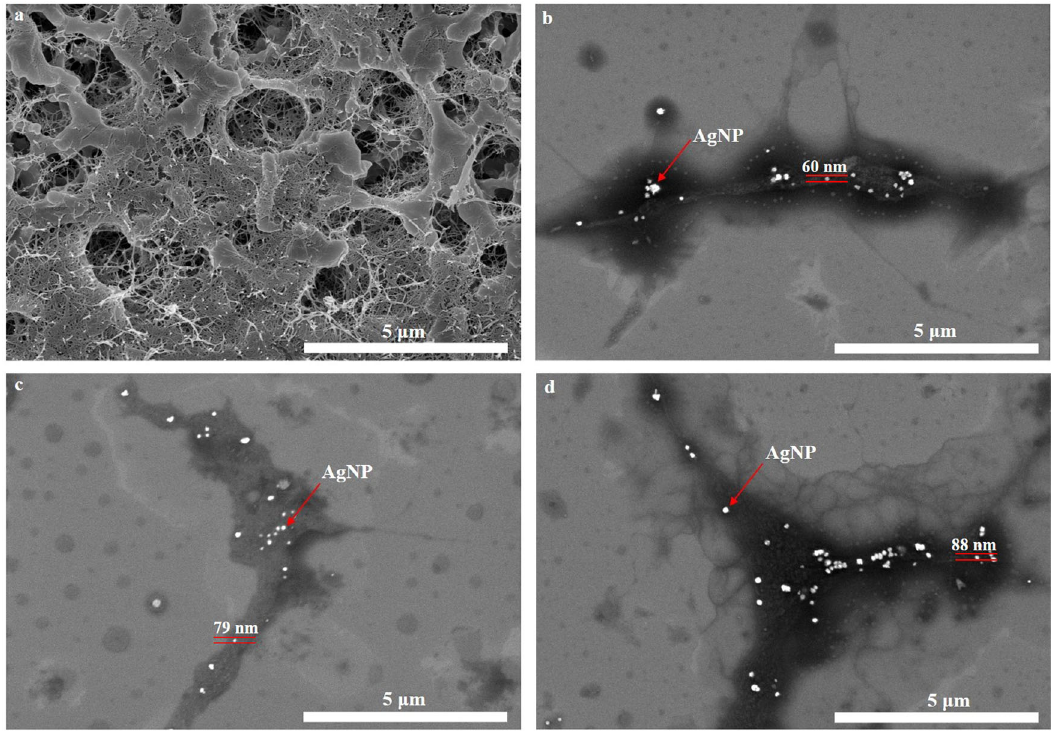
Fig. 1 SEM images of CNF and CNF/Ag nanocomposites. SEM images (scale bar: 5 μ m) of a L-SCNF, b L-SCNF/Ag, c MSCNF/Ag and d